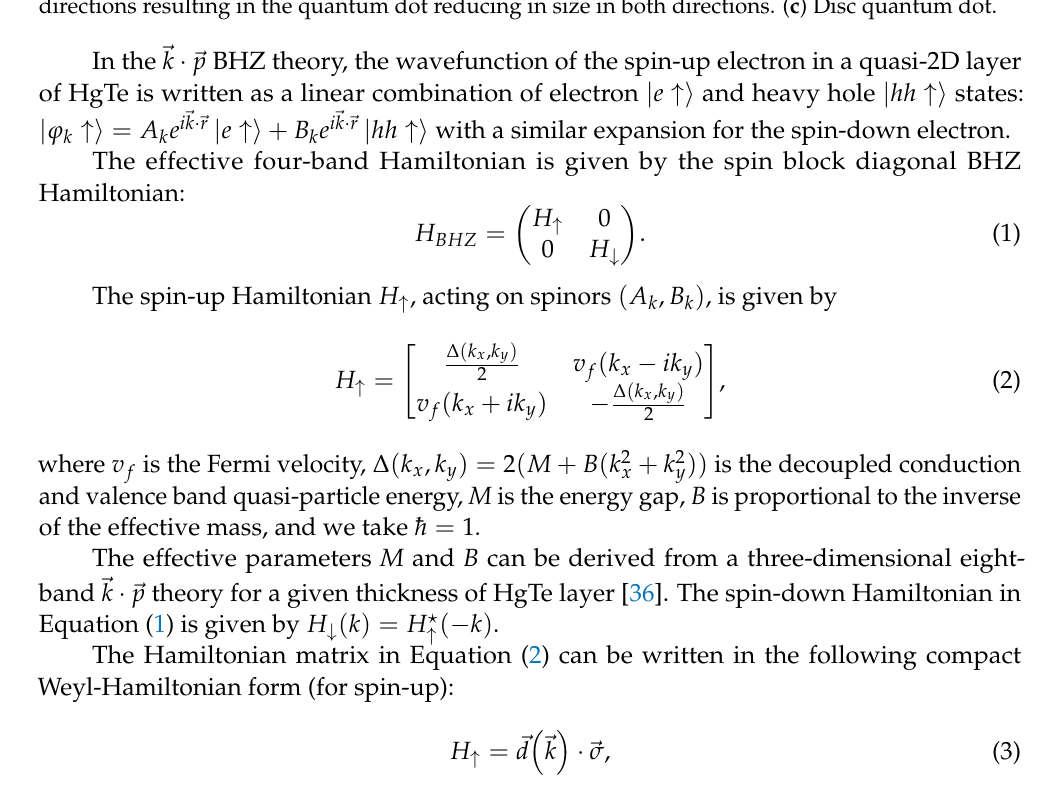
Figure 1. Schematic pictures of quasi-2D HgTe TI quantum dot systems. ( a ) Square quantum dot unstrained. ( b ) Square quantum dot after undergoing compressive strain in the horizontal and vertical directions resulting in the quantum dot reducing in size in both directions. ( c ) Disc quantum